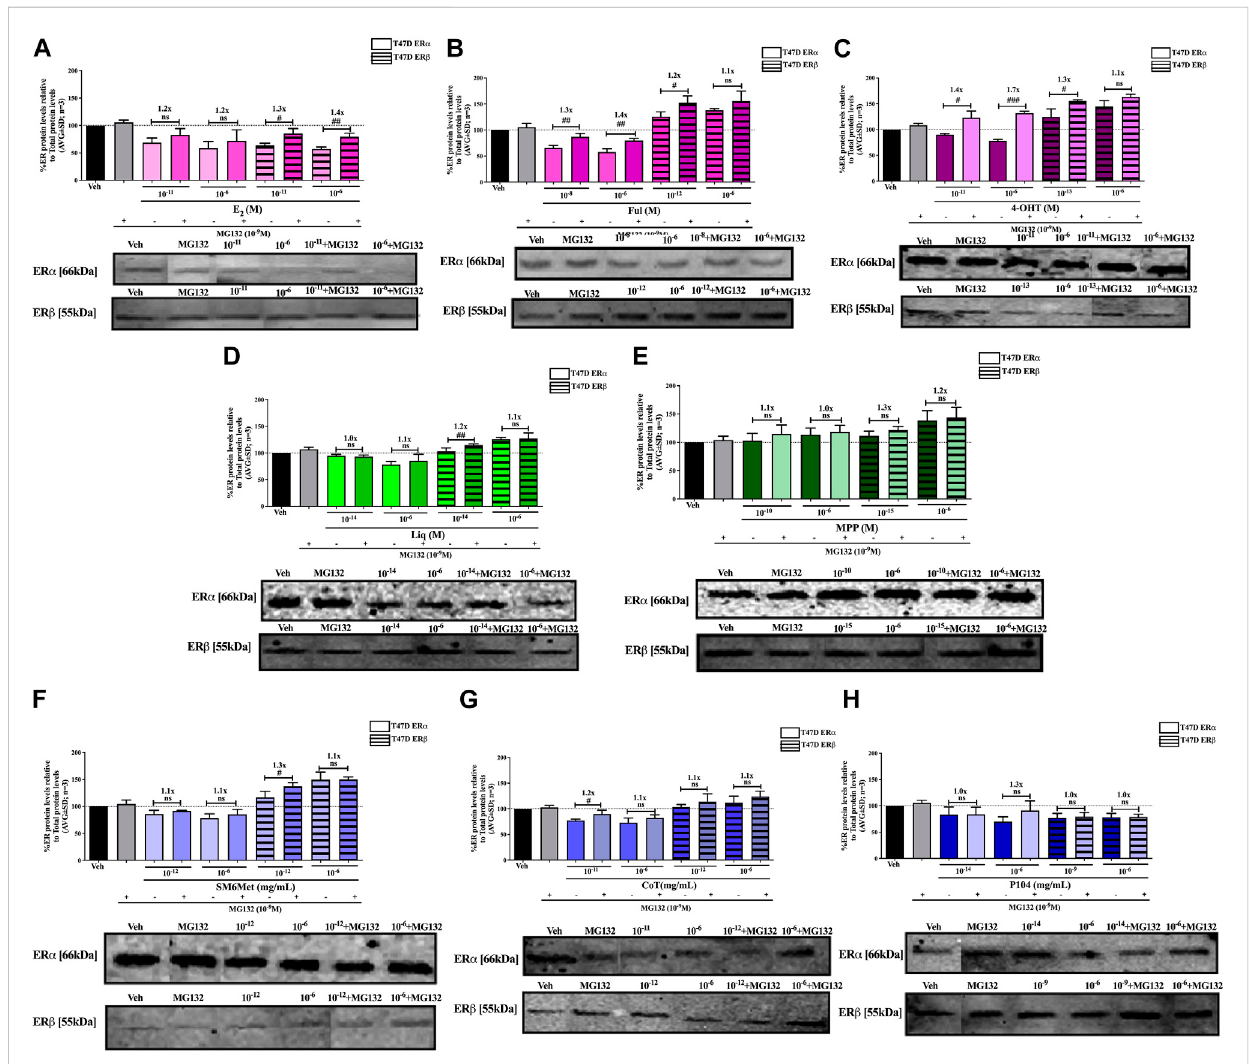
FIGURE 7 Effect of MG132, a UPS inhibitor, on the modulation of ER α and ER β protein levels in T47D cells. T47D cells were steroid starved for 24 h and then treated with either vehicle (DMSO) or LogIC 50 (from Figure 3; Table 2 with µg/ml converted to M) and saturating (1 μ M) concentrations of (A) E 2 or the SOCs, (B) fulvestrant (Ful) or (C) 4-OH-tamoxifen (4-OHT), or the ER subtype selective ligands, (D) liquiritigenin (Liq) or (E) methyl-piperidino-pyrazole (MPP),orLogIC 50 (fromFigure3inµg/ml)andsaturating(10 − 6 μ g/ml)concentrationsofthe Cyclopia extracts, (F) SM6Met, (G) cupoftea(CoT)or (H) P104inthepresenceorabsenceof1 nMMG132foranother24 h,afterwhichtheeffectof±MG132onER α andER β proteinlevelsweredeterminedusing Westernblot.Thewesternblotsshownasinsertarerepresentativesofthreeindependentexperiments.Forquanti fi cation,theintensityoftheER α andER β bands were determined with MyImage Analysis software, after which the obtained values were normalized to total protein content and expressed as a percentage(AVG±SD)ofDMSO,whichwassetat100%.Fold-changeisindicatedabovethebars.Statisticalanalysiswasdoneusingatwo-tailed t -testto establish signi fi cant differences due to addition of MG132 ( # p < 0.05, ## p < 0.01 and ### p <